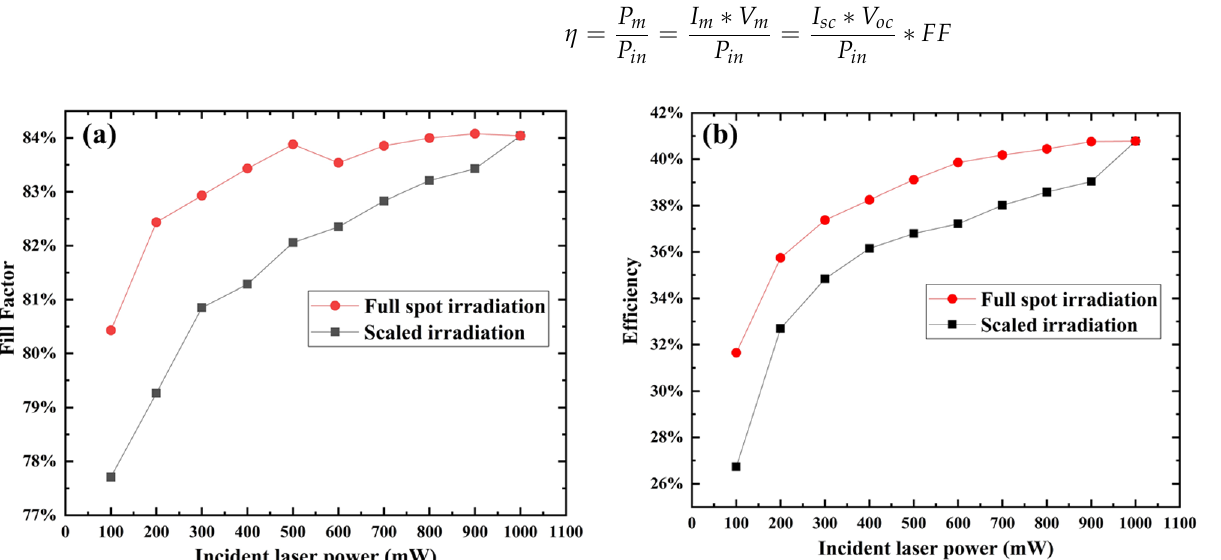
Table 1. Series resistance of laser photovoltaics under different laser illumination scales.